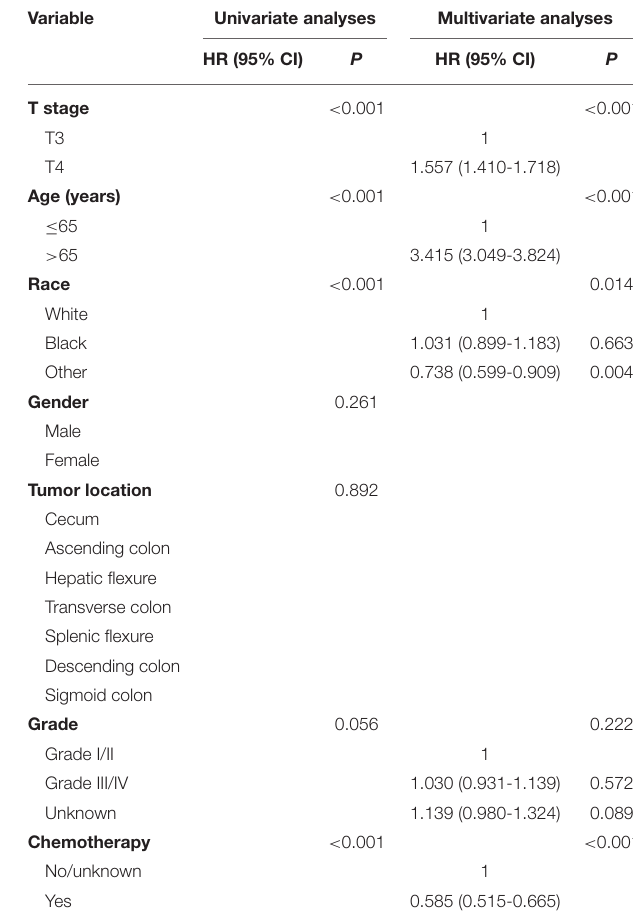
TABLE 4 | Univariate and multivariate analyses of prognostic factors in stage II MUA. Variable Univariate analyses Multivariate